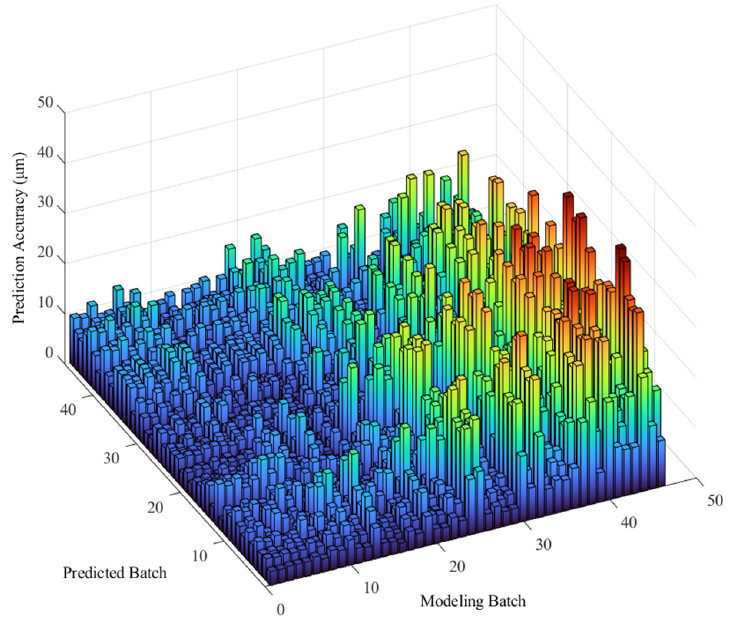
Figure 6. Mutual prediction results of 46 batches of experiments .